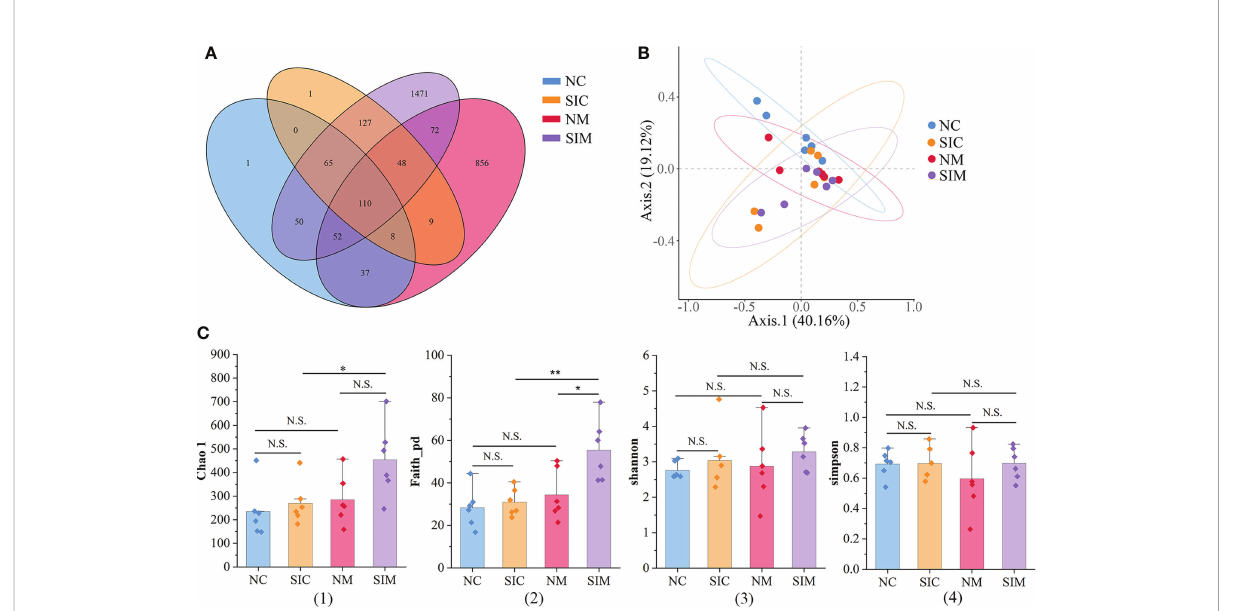
FIGURE 3 Effects of soybean iso fl avones on the gut microbiota diversity of normal mice ( n = 6). (A) Operational taxonomic unit (OTU) numbers of the gut microbiota of different groups. (B) Beta diversity of the gut microbiota (PCoA, Bray-Curtis distance). (C) Alpha diversity of the gut microbiota. (1) Chao 1, (2) Faith_pd, (3) Shannon, (4) Simpson. NC, lumen-associated bacteria of the normal group; SIC, lumen-associated bacteria of the soybean iso fl avones group; NM, mucosa-associated bacteria of the normal group; SIM, mucosa-associated bacteria of the soybean iso fl avones group. N.S., no signi fi cance ( P > 0.05), * P < 0.05, ** P <